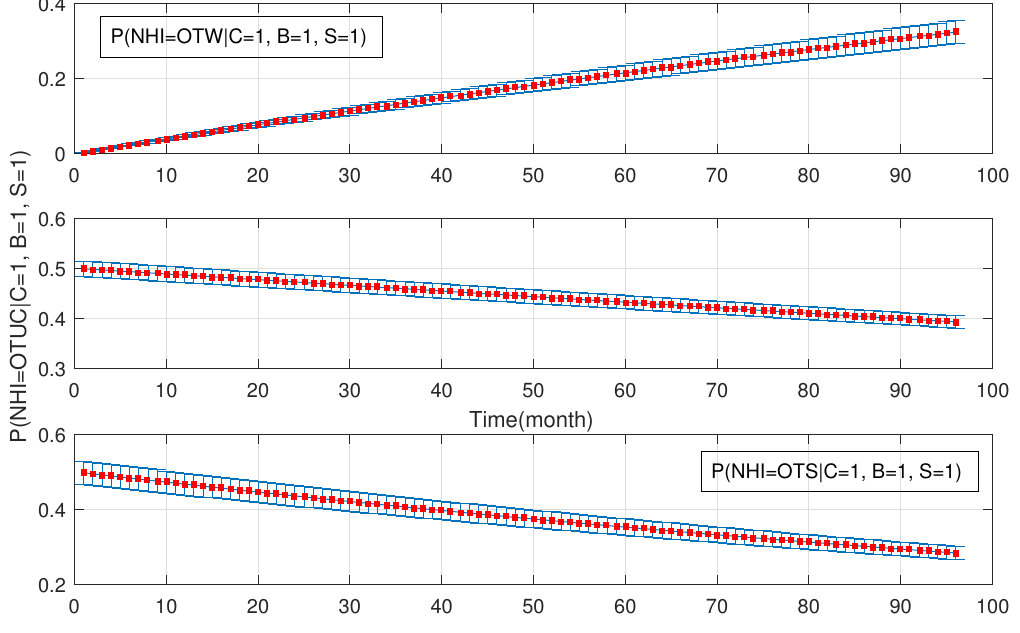
Figure 14. The probability of new herd incident (NHI) (officially TB free status withdrawn (OTW), officially TB free status unclassified (OTUC), officially TB free status suspended (OTS)) in high-risk areas of England where B: badgers density is > 3 setts/ha; S: silage fed; and C: manure stored for more than six months. probability of NHI, when evidences, C=2, B=1 and S=1, is given in the high-risk areas of England